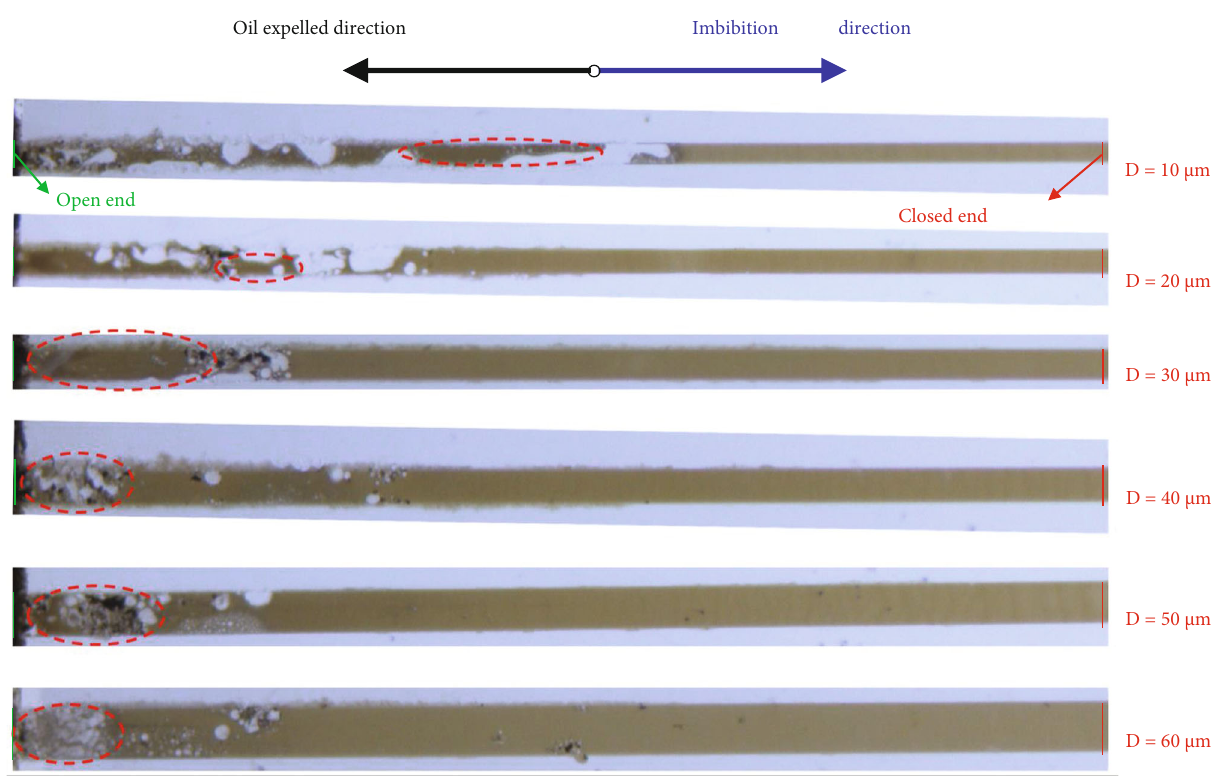
Figure 4: Final results of spontaneous imbibition in the left open-end location of capillaries with six di ff erent diameters.